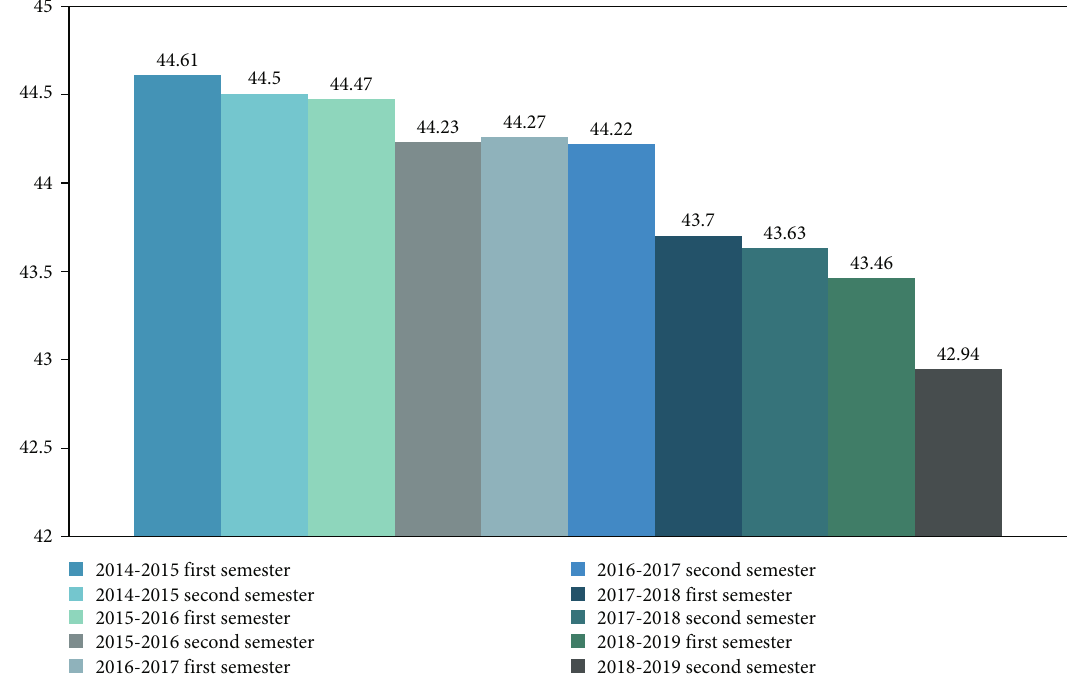
Figure 7: The proportion of fi rst-class teachers has changed in the past fi ve